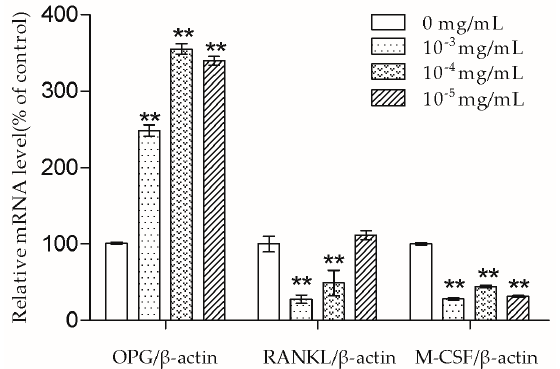
Figure 5. TSG up-regulated the osteoprotegerin (OPG) mRNA level, and down-regulated the nuclear factor- κ B ligand (RANKL) and macrophage colony-stimulating factor (M-CSF) mRNA levels of the MC3T3-E1 cells. Data are represented as the mean ± SD of three determinations. ** p < 0.01 when compared with the control group.